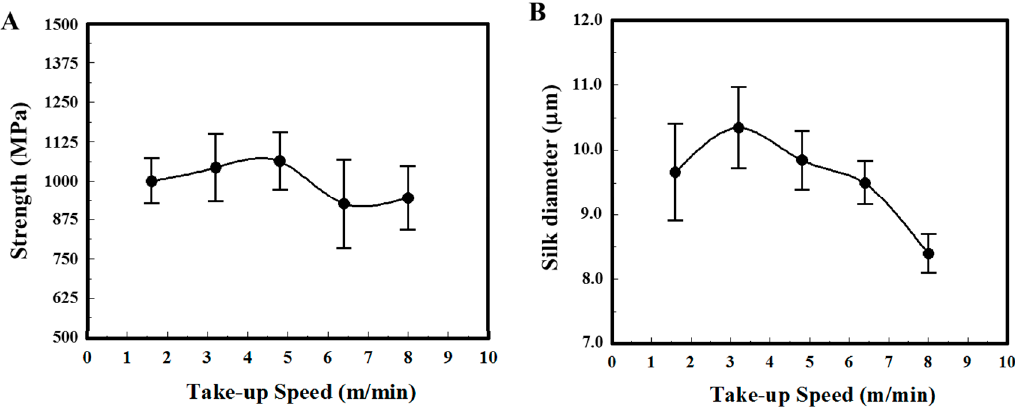
Figure 1. Physical properties of dragline silk from N. pilipes. ( A ) Strength (MPa) and ( B ) diameter ( μ m) under different take-up speeds.